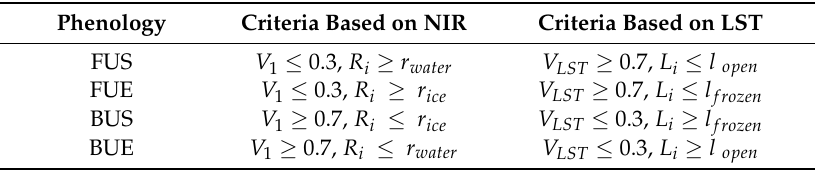
Table 3. Two-step criteria of phenology determination based on land surface temperature (LST)